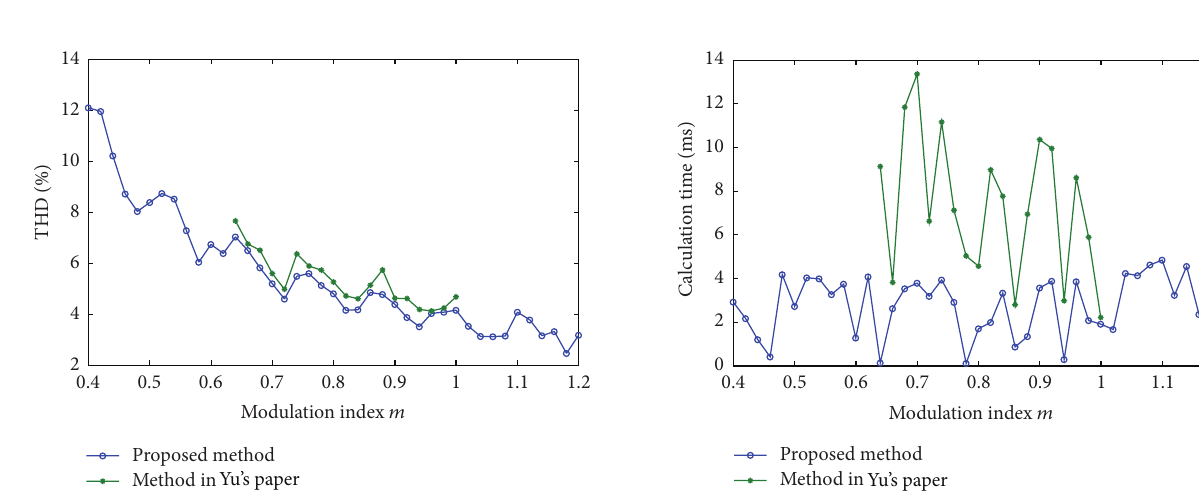
Figure 7: Comparison of THD between the proposed method and the previous method.